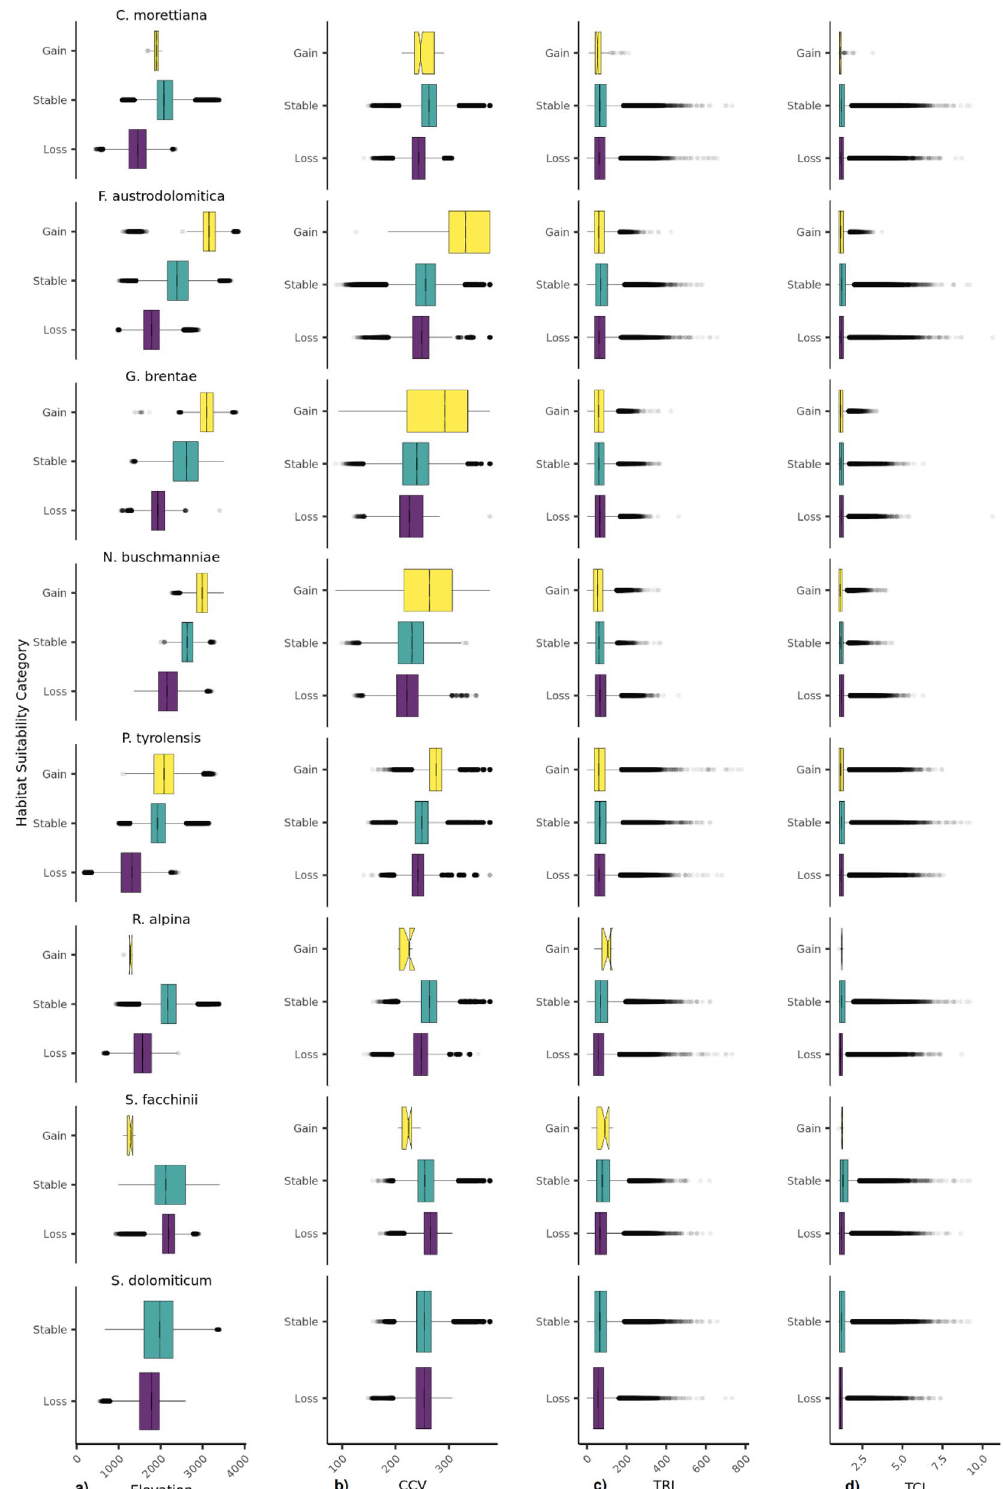
Figure 2. Boxplot for each category of habitat suitability (loss, stable, gain) for the intermediate rcp 4.5 scenario for ( a ) elevation (m a.s.l.), ( b ) climate change velocity (log10(m yr −1 )*100), ( c ) topographical ruggedness index (TRI) and ( d ) topographical complexity index (TCI) for each of the eight study species. After the pairwise Mann–Whitney tests all the categories showed significant differences, with the following non-significant exceptions for the rcp 4.5 scenario: gained areas compared to lost and stable areas for TCI and TRI in R. alpina and S.